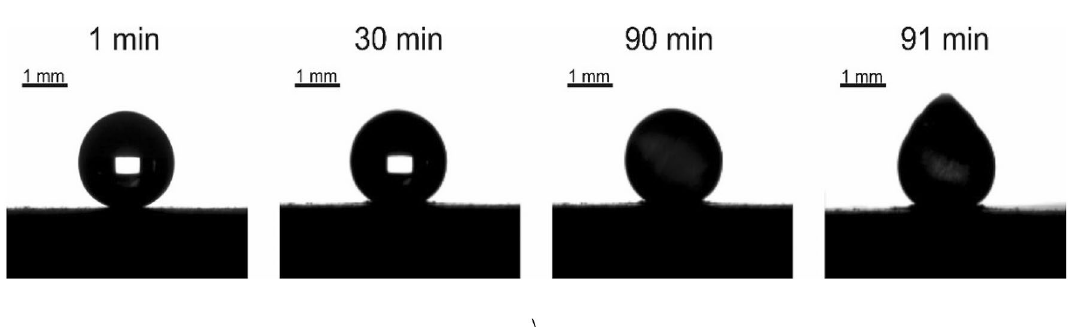
Figure 8. Time evolution of the shape of the 2 μl water droplet placed on the cooled icephobic surface at t = − 15 °C at RH = 80% is shown. The typical tip is formed at the top of the droplet at final stage of cooling. Scale bar is 1